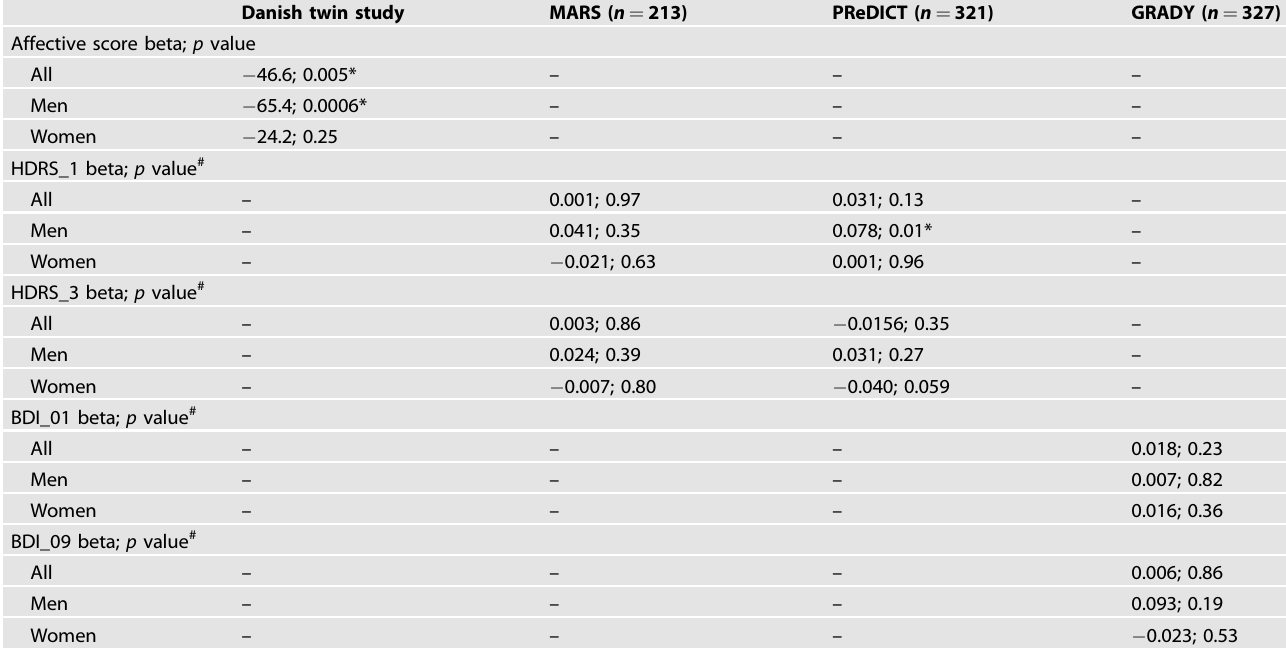
Table 4. Associations between TLR4 cg05429895 methylation levels and affective score, HDRS and BDI in the Danish twin study, MARS, PReDICT and GRADY cohorts.